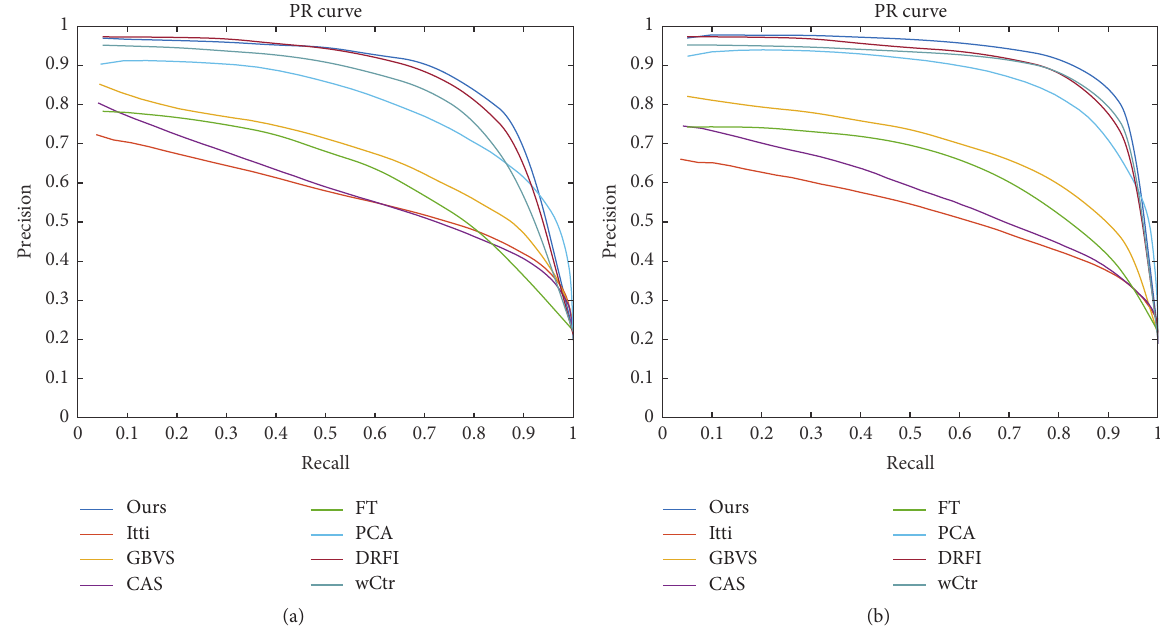
Figure 6: Precision-recall (PR) curves for all algorithms. (a) PR curves on MSRA10K dataset. (b) PR curves on ASD dataset.